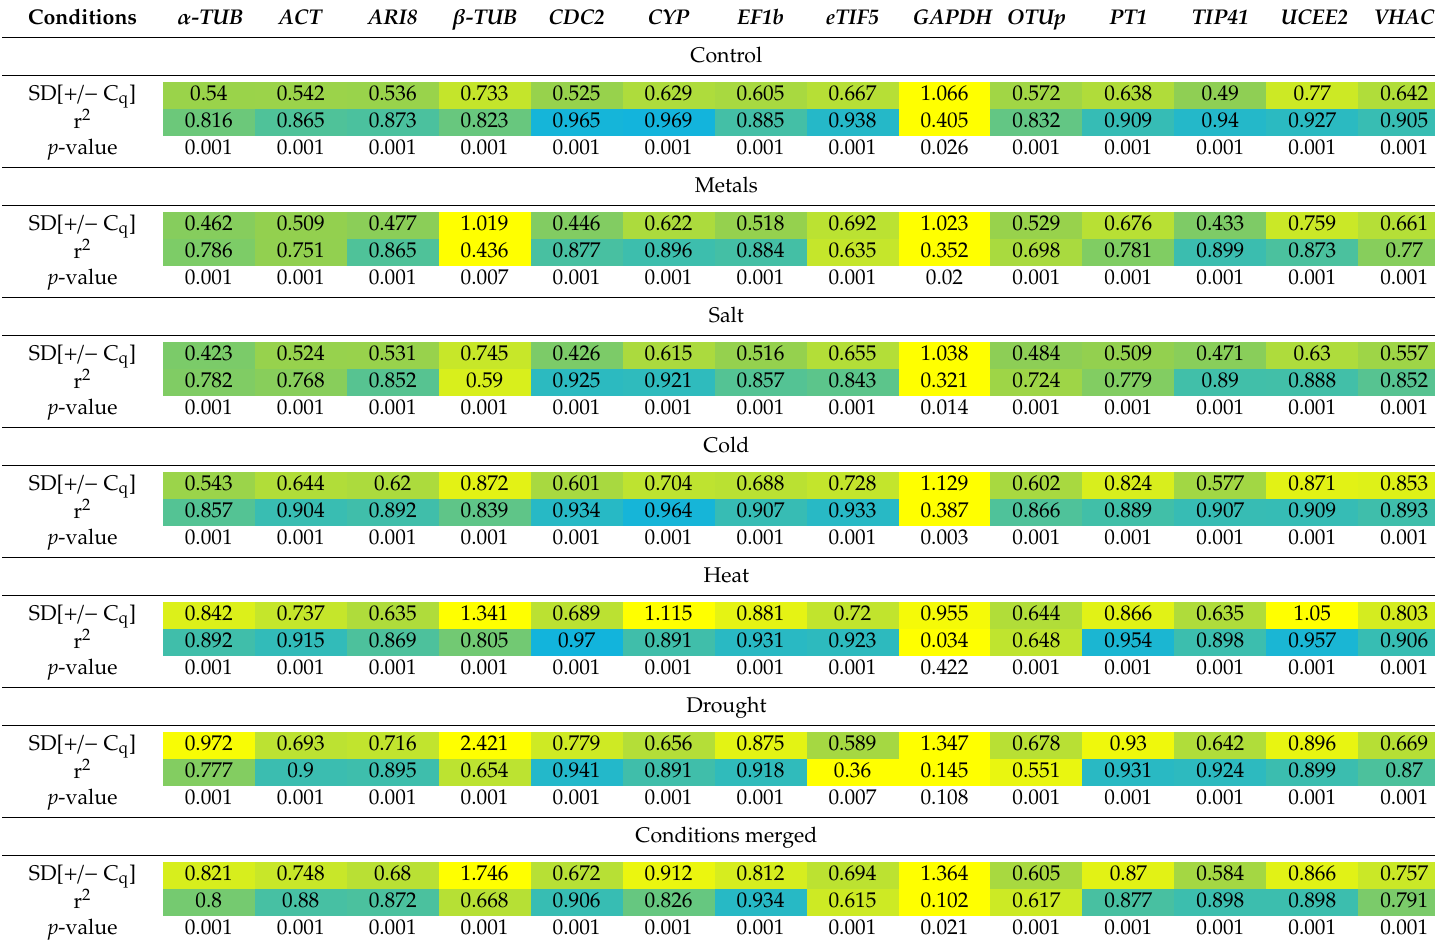
Table 4. Potential RGs to normalize qPCR data in Salix viminalis roots exposed to various abiotic stresses. Plants were exposed to the stresses for up to two months. Gene expression stability was calculated with BestKeeper. Two stability values are given: standard deviation SD [ +/ − C q ] (the lower, the better) and by the coe ffi cient of determination (r 2 ) (the closer to 1, the better). Genes with SD [ +/ − Cq] over 1 should be discarded. Color scale: the bluer, the more